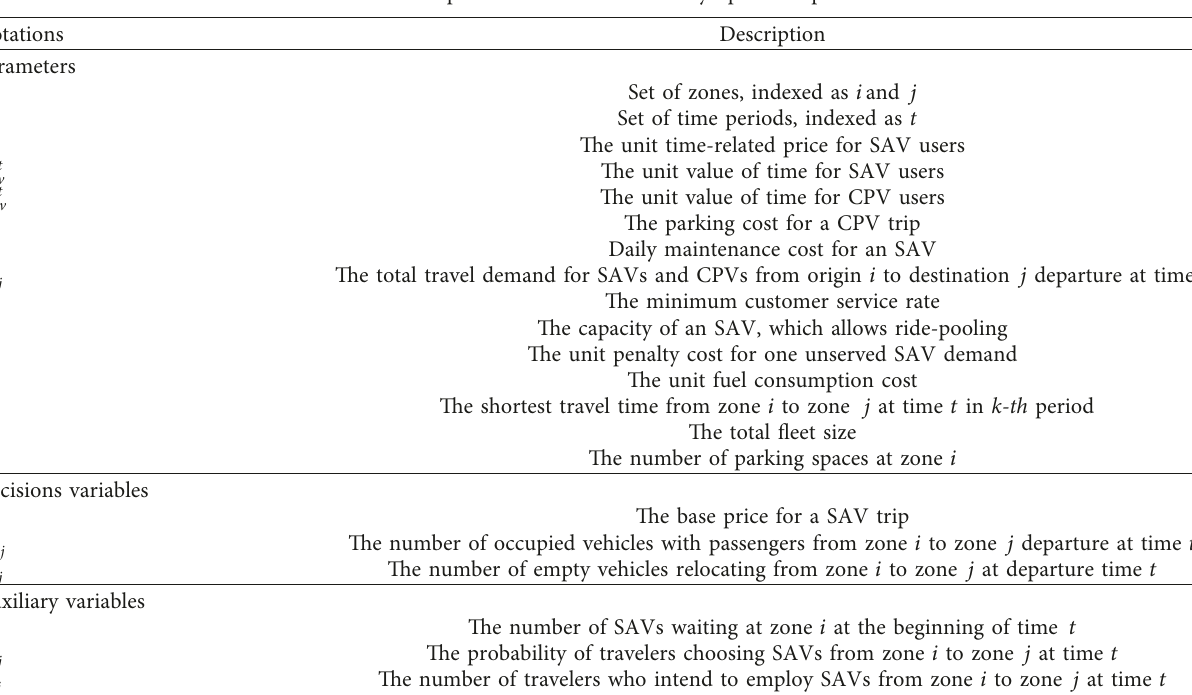
Table 1: Variables and parameters used in the daily operation problem